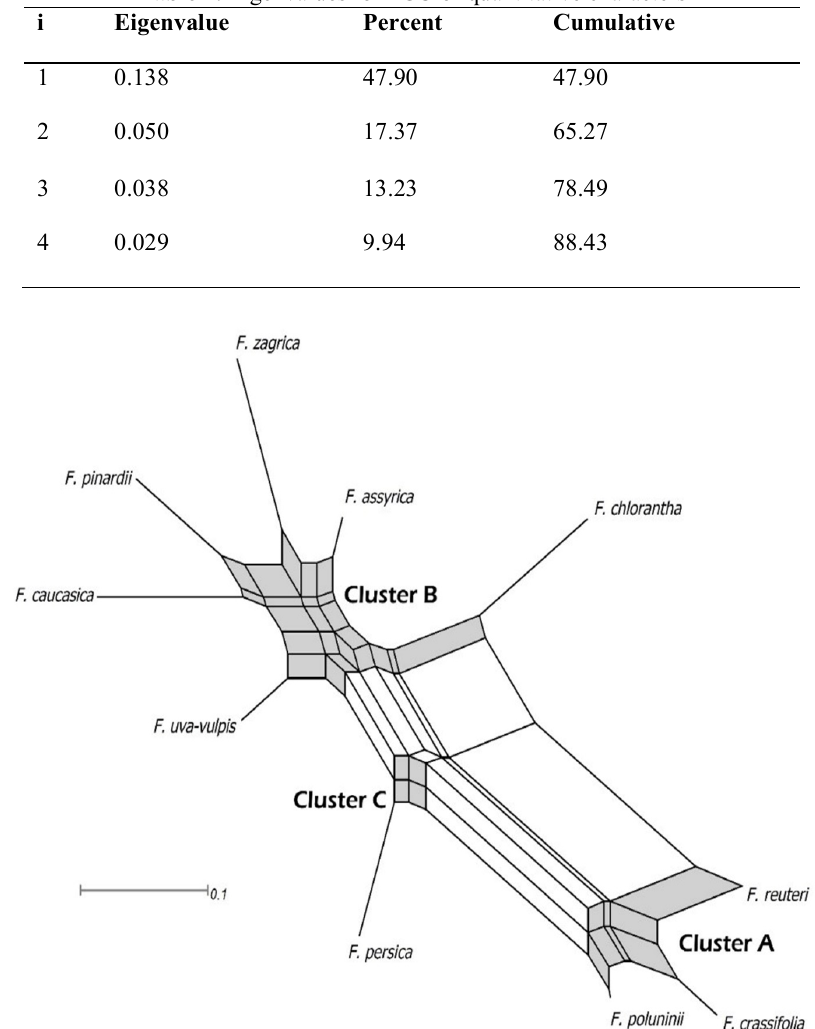
Table 4. Eigenvalues for PCO of quantitative characters